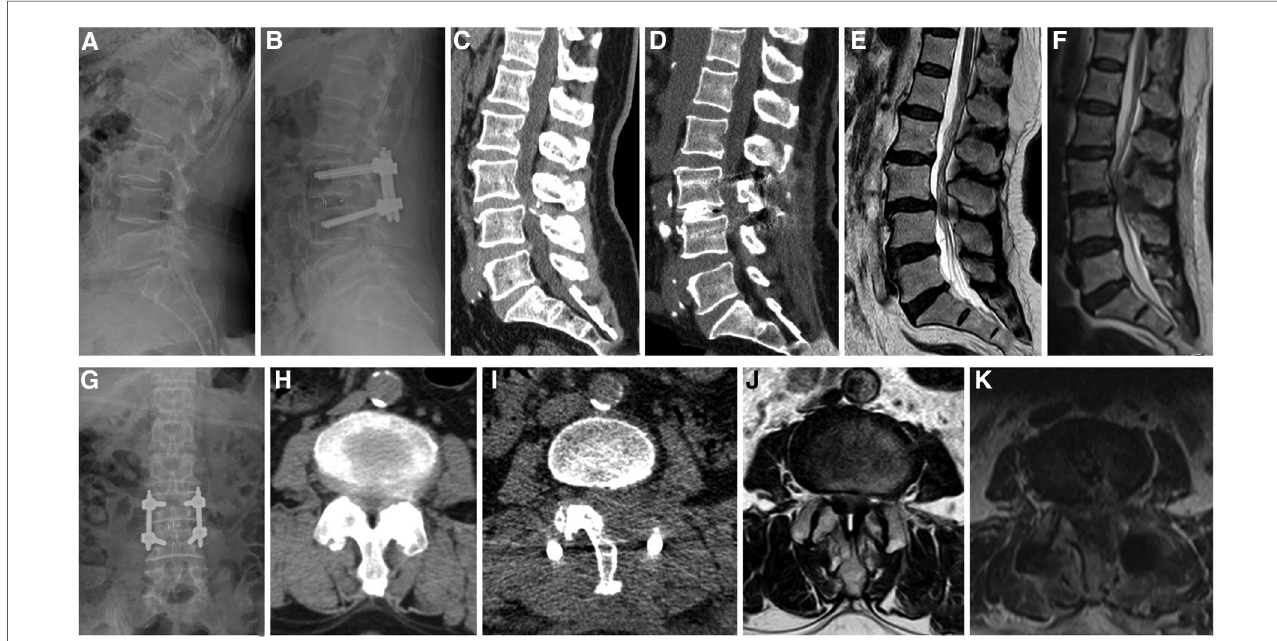
FIGURE 2 A 62-year-old female patient, whose complaints were low back pain since 3 years, lower limbs numbness, and intermittent claudication since 5 months. ( A,C, E ) Preoperative lateral radiographs, sagittal CT, and MRI showing instability of the L3 vertebral body, L3 – 4 spinal stenosis, and ossi fi cation of the posterior ligamentum fl avum. ( H,J ) Preoperative axial CT and MRI showing signi fi cant spinal stenosis in L3 – 4. ( B,G ) Postoperative anteroposterior and lateral radiographs showing a good position of the instrumentation and the cage and improved segmental instability. ( D ) Postoperative sagittal CT showing that adequate bone was grafted. ( F ) Postoperative sagittal MRI showing that spinal stenosis was improved. ( I ) Postoperative axial CT showing unilateral laminectomy bilateral decompression. ( K ) Postoperative axial MRI showing suf fi cient decompression and a good position of the